Question: Draft a figure caption describing what is shown.
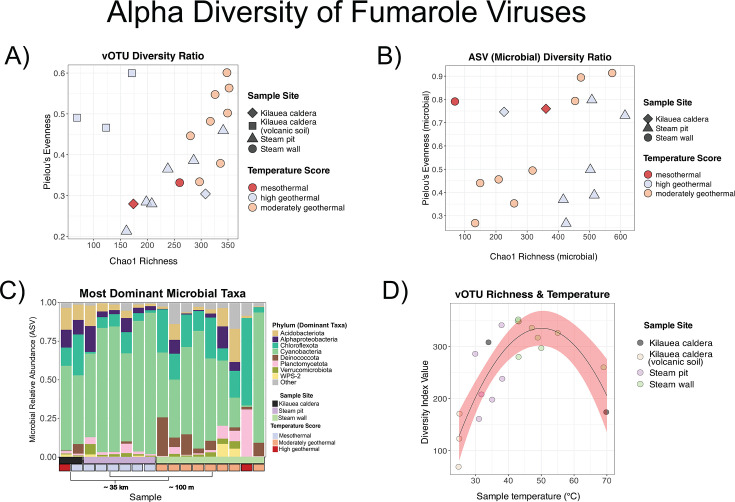
Answer: ( A ) Richness (Chao1) and evenness (Pielou) of fumarole vOTUs calculated from RPKM-based relative abundances ( Table S6 ). Each point represents a sample. Shape indicates sample site, and color indicates temperature at the time of collection. ( B ) Richness and evenness of microbial ASV relative abundances. Each point represents a sample; color and shape denote sample characteristics as described in panel A . ( C ) Relative abundance of the most abundant bacterial taxa across samples based on ASVs. The top five phyla per sample are shown and used for visualization. The second row indicates sample site, and the bottom row indicates temperature at collection. The phylogram shows spatial relationships among sites: the steam pit and steam wall are ~100 m apart, while the Kīlauea caldera cave is ~35 km from both. ( D ) Sample temperature versus vOTU richness (Chao1). Each point represents a sample, colored by site. vOTU richness follows a temperature-dependent pattern modeled by a polynomial (quadratic) regression. Richness increases with temperature up to ~50°C and declines thereafter.